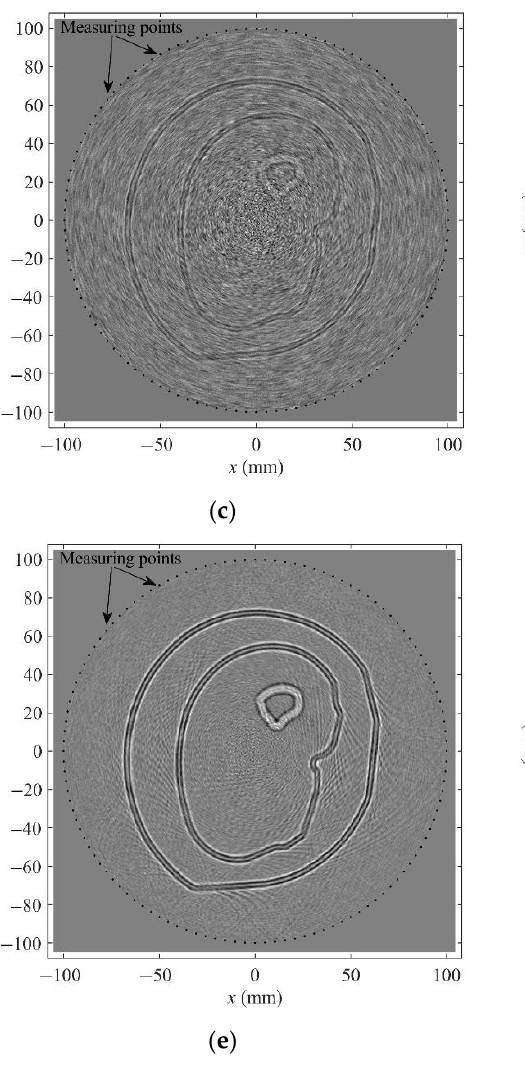
Figure 9. Reconstructing the acoustic source position in the case of SNR level: ( a ) 3 dB; ( b ) 5 dB; ( c ) 8 dB; ( d ) 10 dB, ( e ) 25 dB; and ( f ) 40 dB.